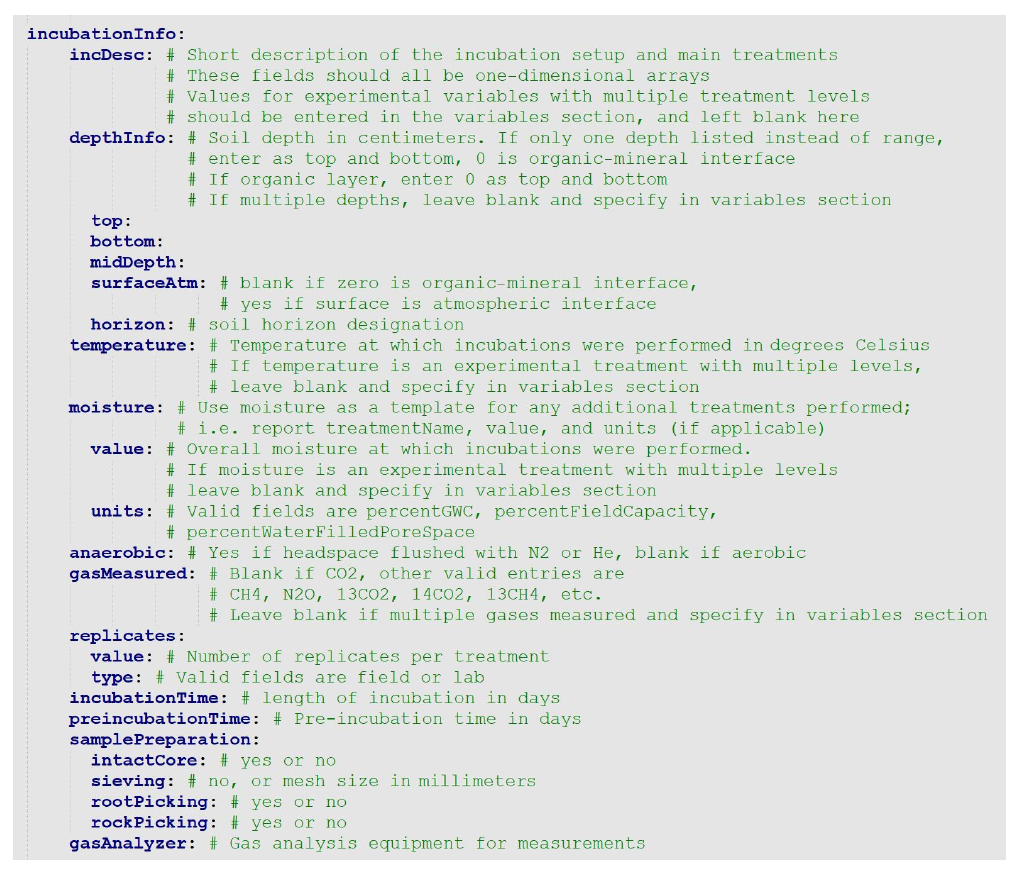
Figure 4. Incubation information for each database entry.